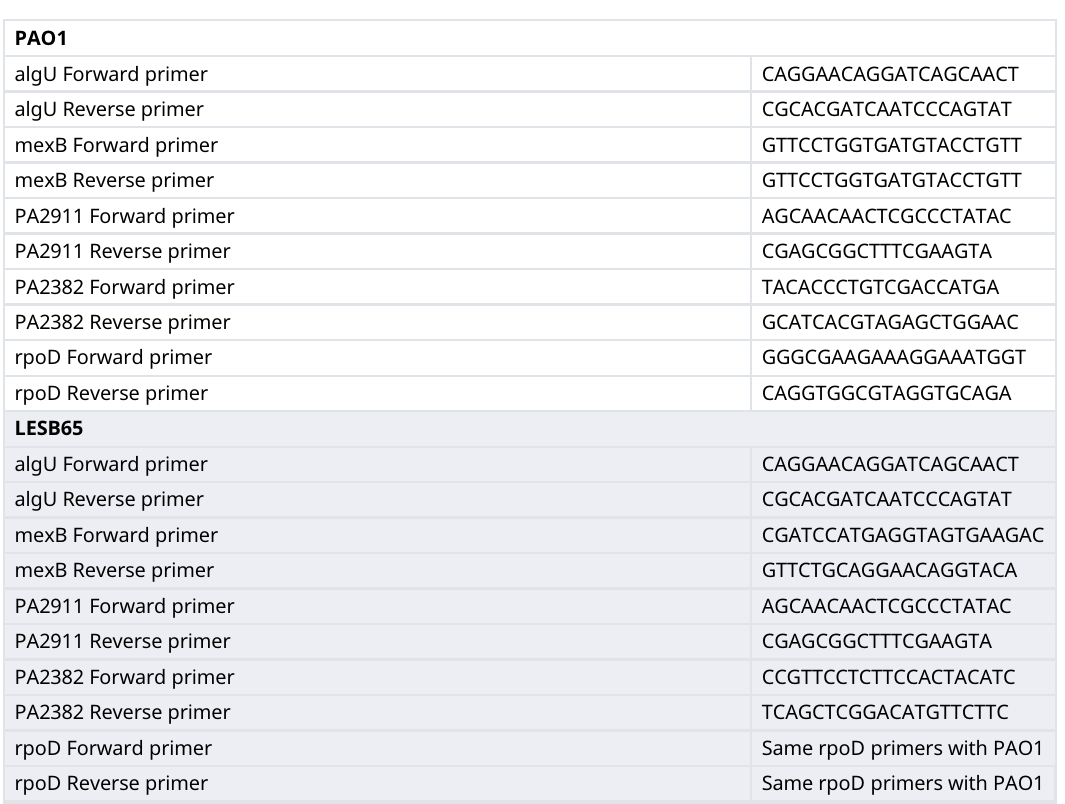
Table 4. qPCR was performed using the BioRad CFX Connect Real Time PCR System (BIORAD) using MicroAmp ™